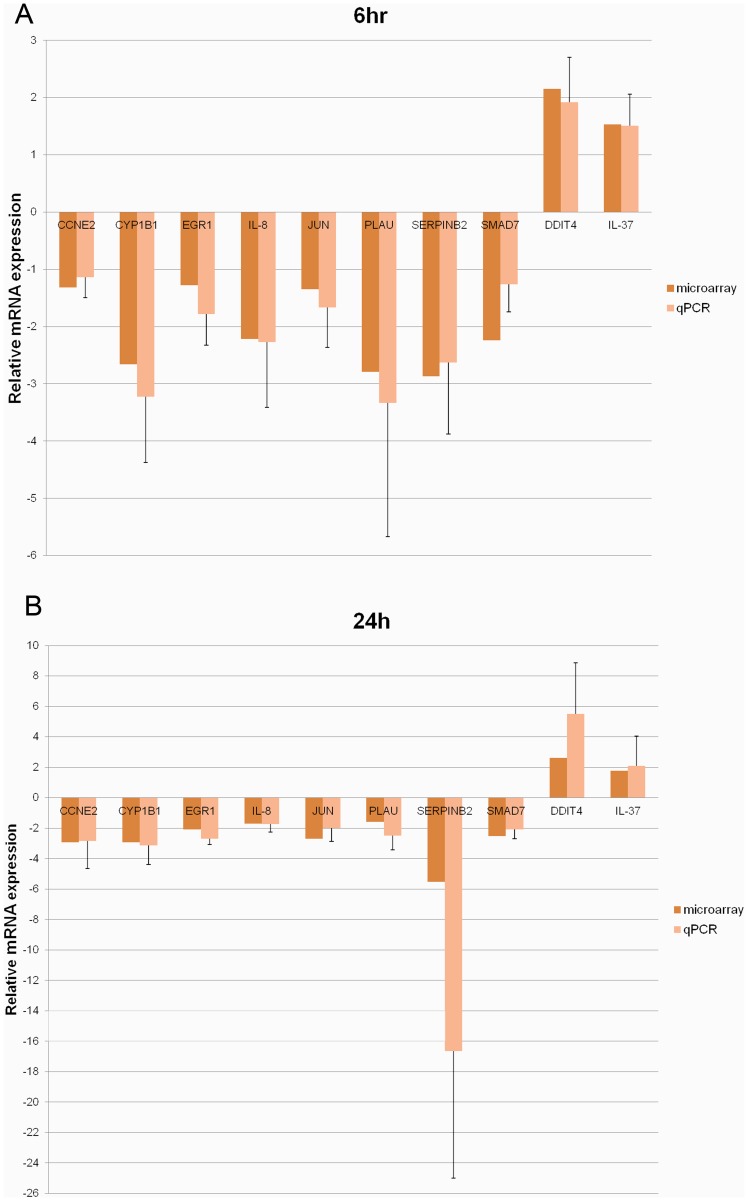
Validation of the expressions of selected genes by real-time PCR.(A) 6 hr. (B) 24 hr. Real-time PCR results are represented as mean± SD of at least 3 independent experiments